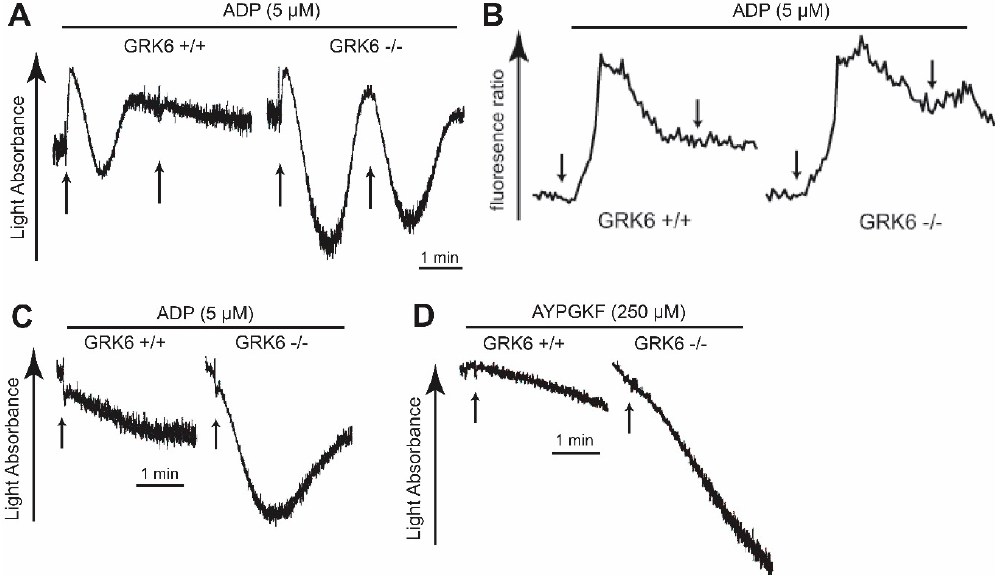
Figure 4. Desensitization of platelet aggregation in response to adenosine diphosphate (ADP) and AYPGKF in GRK6-deficient platelets. ( A ) Platelets from GRK6 +/+ and GRK6 − / − mice were stimulated with 5 µM ADP for 3 min. Platelets were re-stimulated with 5 µM ADP for 3 min. ( B ) Fura-2-AM-loaded platelets from GRK6 +/+ and GRK6 − / − mice were stimulated with 5 µM ADP for 3 min and re-stimulated with 5 µM ADP. Intracellular Ca 2+ increase was measured. ( C ) Platelets from GRK6 +/+ and GRK6 − / − mice were stimulated with 5 µM ADP after 3 min pre-incubation with 5 µM ADP. ( D ) Platelets from GRK6 +/+ and GRK6 − / − mice were stimulated with 250 µM AYPGKF after 30 min pre-incubation with 250 µM AYPGKF. Results are representative of three independent experiments.